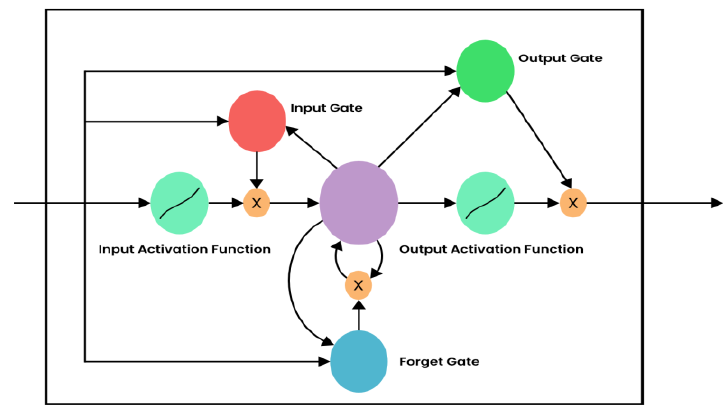
Figure 2. LSTM Architecture for IDS.